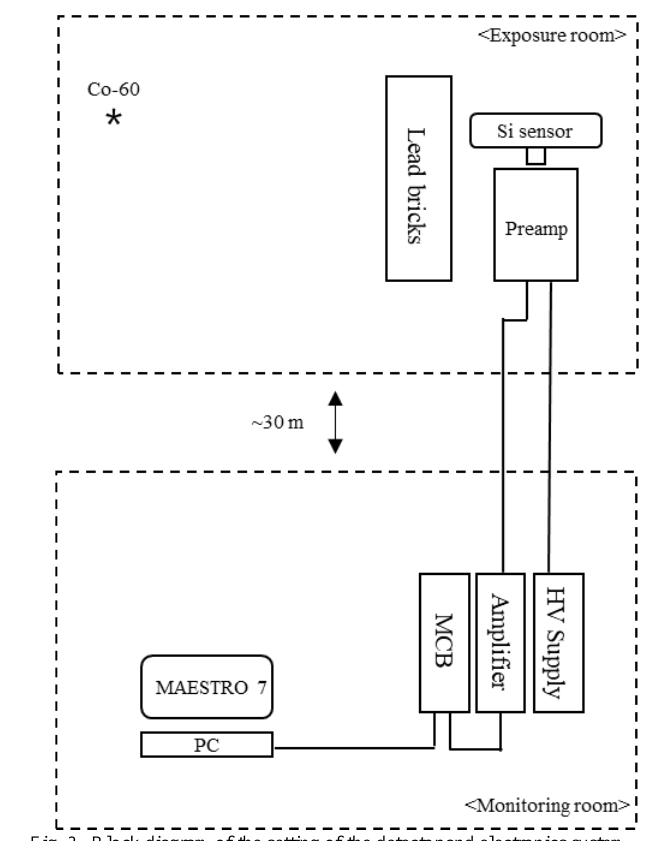
Fig. 3. Block diagram of the setting of the detector and electronics